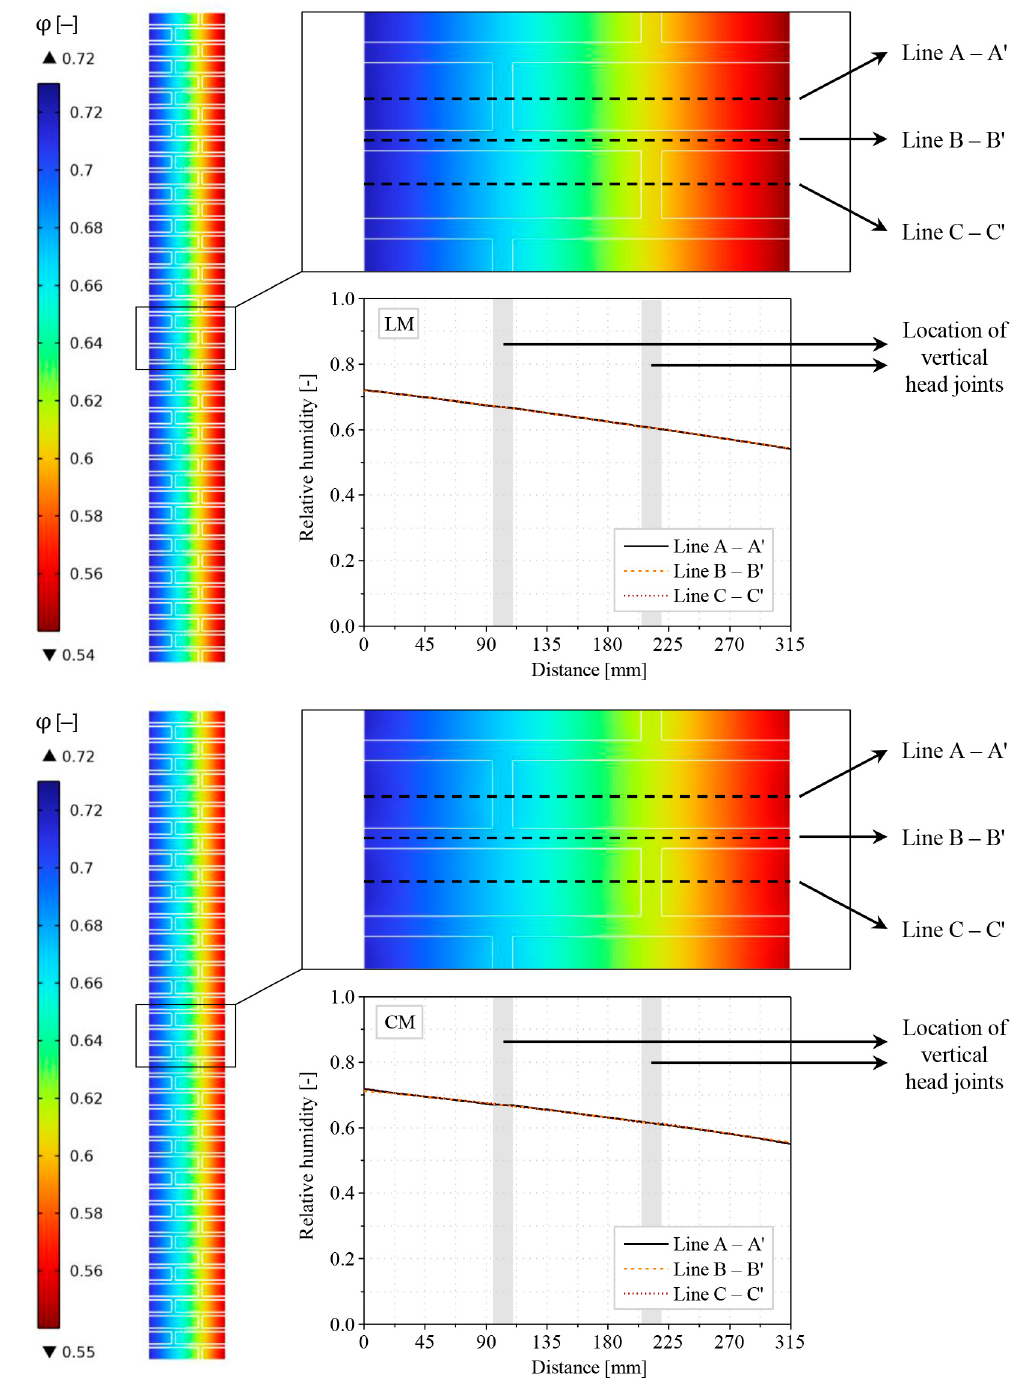
Figure 4. Steady-state analysis (SS). Relative humidity distribution across the studied three-wythe brick masonry wall: ( a ) joints with lime mortar (LM); ( b ) joints with cement mortar (CM).